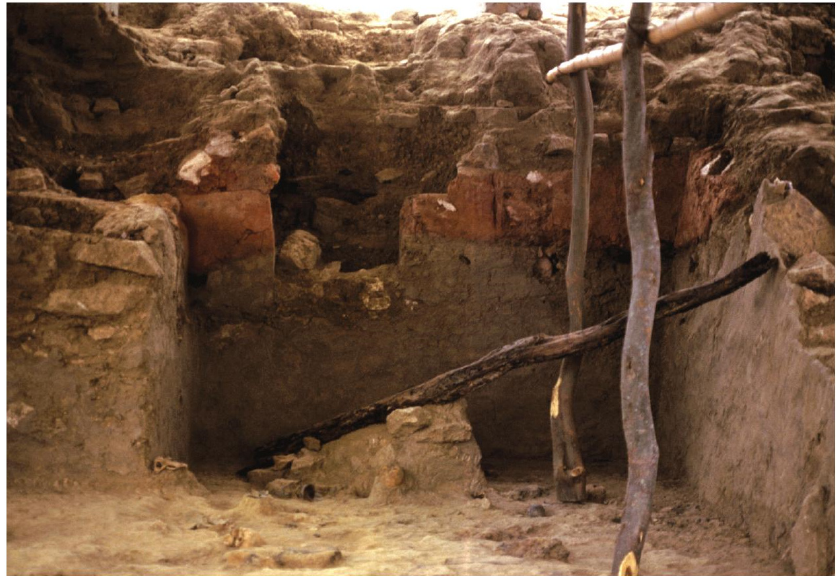
Figure 6. Evidence of post-Conquest burning in the Inka Stone Structure on the Huaca Larga at Túcume. The room had been filled prior to burning, with two pairs of Early Colonial glass bead earrings ([3]:97 and Figure 60). (Photo by Daniel H. Sandweiss).